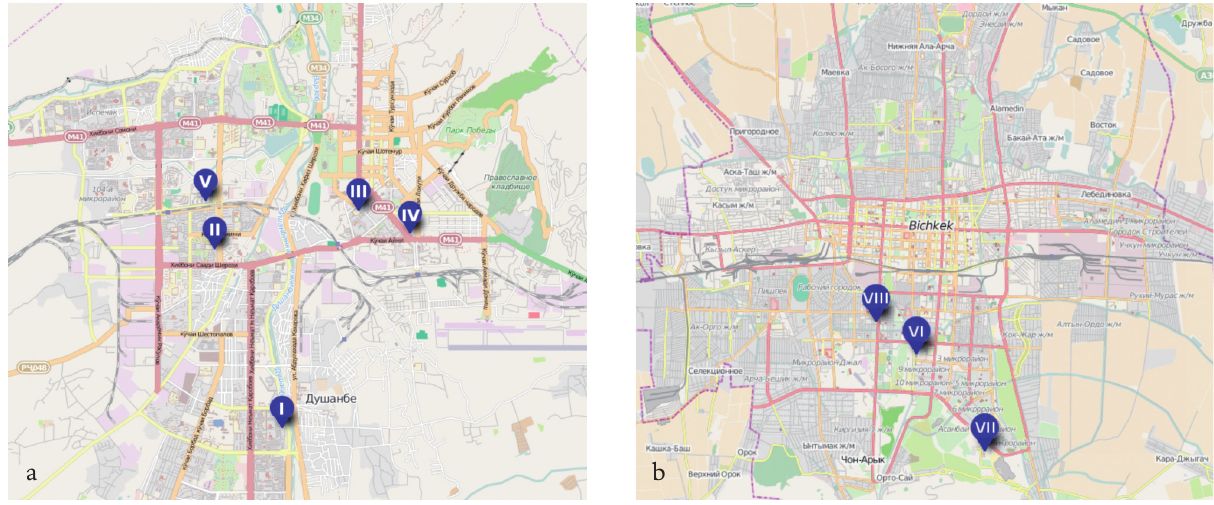
a Figure 1. Map with the locations of the monitored buildings in (a) Dushanbe and (b) Bishkek.